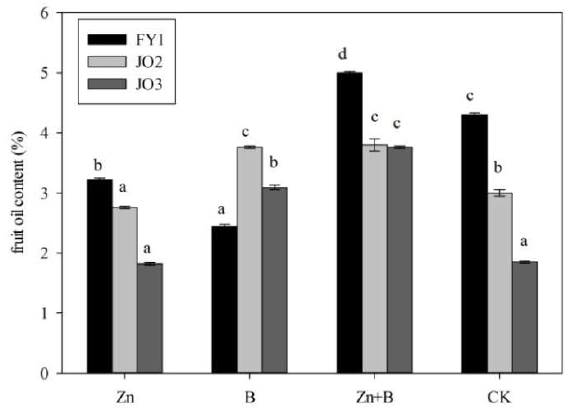
Figure 3. Effects of the foliar applications of the micronutrient solutions on the oil content in L. cubeba .